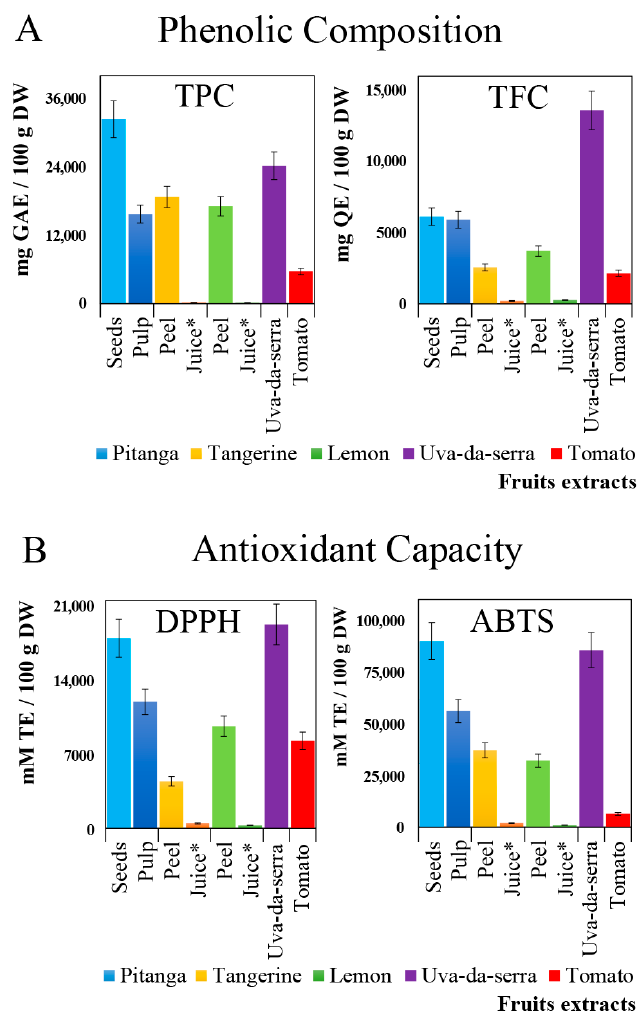
Figure 3. Evaluation of the phenolic composition ( A ) and antioxidant capacity ( B ) of the selected fruit extracts, pitanga (seeds and pulp), tangerine (peel and juice), lemon (peel and juice), uva-da-serra (whole fruits) and tomato (whole fruits). The phenolic composition was evaluated through